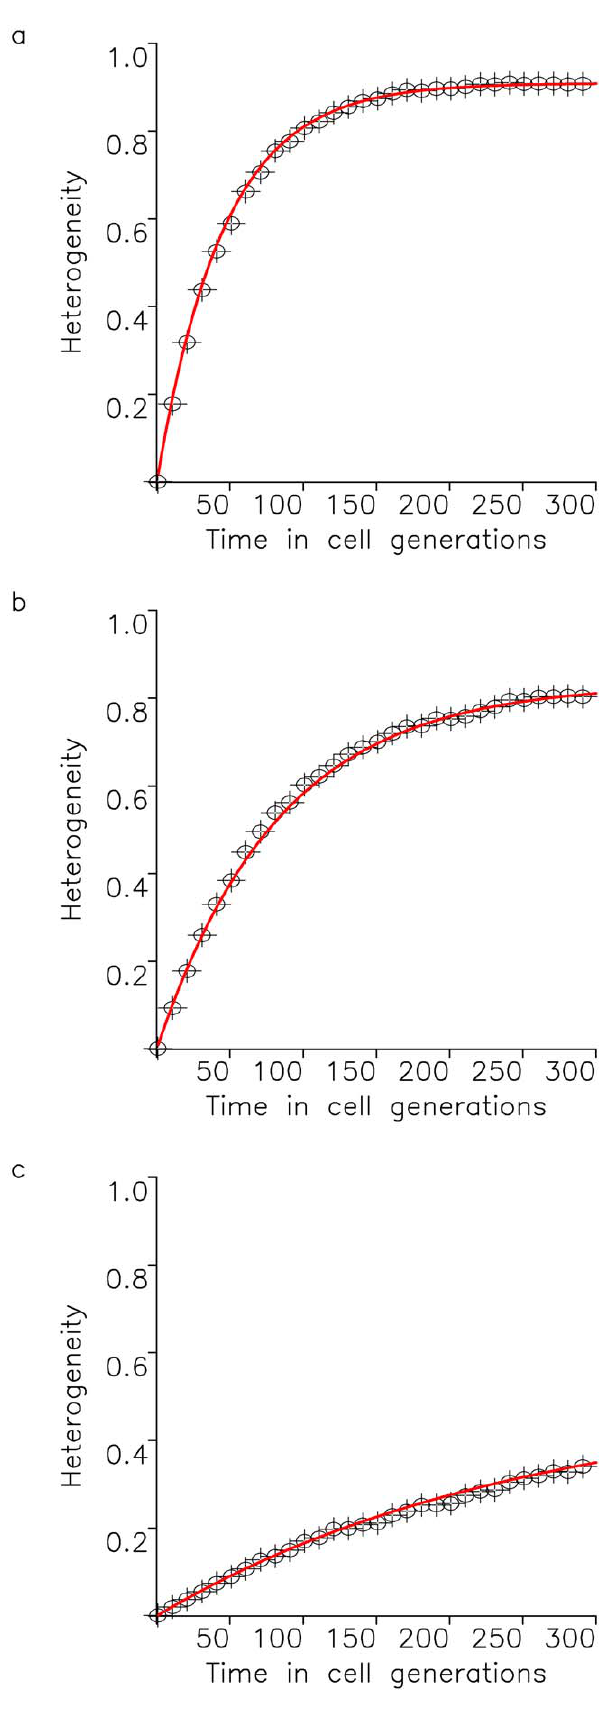
Figure 2. Tumor heterogeneity due to neutral variation. A cell population of fixed size, N , accumulates neutral mutations at rate u per cell division. All cell types have growth rate R and death rate D . The figure shows the fit of the exact stochastic computer simulation of this process with equation (5). In the simulation, heterogeneity is defined as Simpson’s index, equation (1). Parameters are N ~ 1000 , R ~ D ~ 1 , I ~ 10 4 , and u ~ 10 { 2 in (a), u ~ 5 : 10 { 3 in (b), and u ~ 10 { 3 in (c), and results are averaged over 100 simulation